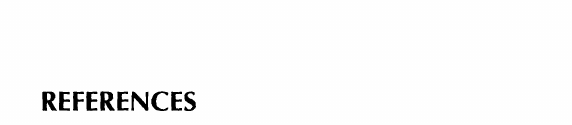
FIGURE 11 Measured original and updated FE point FRFs